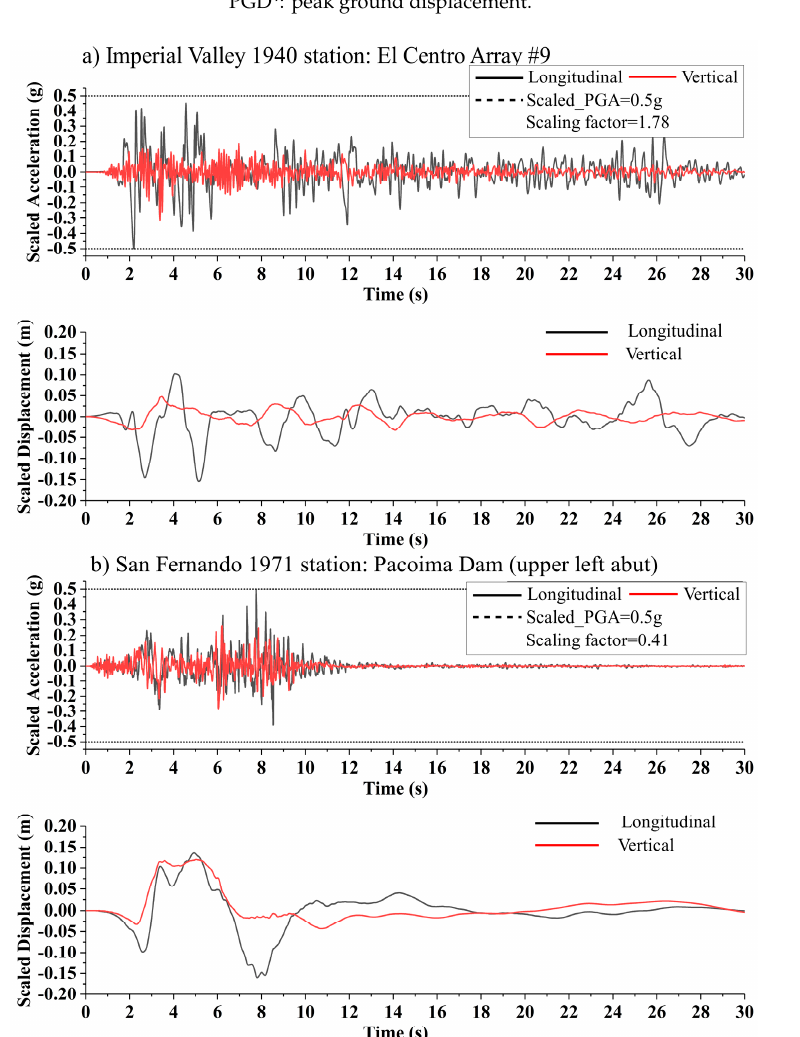
Figure 6. Acceleration and displacement of two selected earthquakes, ( a ) the scaled acceleration and the displacement of the Imperial Valley 1940 earthquake, ( b ) the scaled acceleration and the displacement of the San Fernando 1971